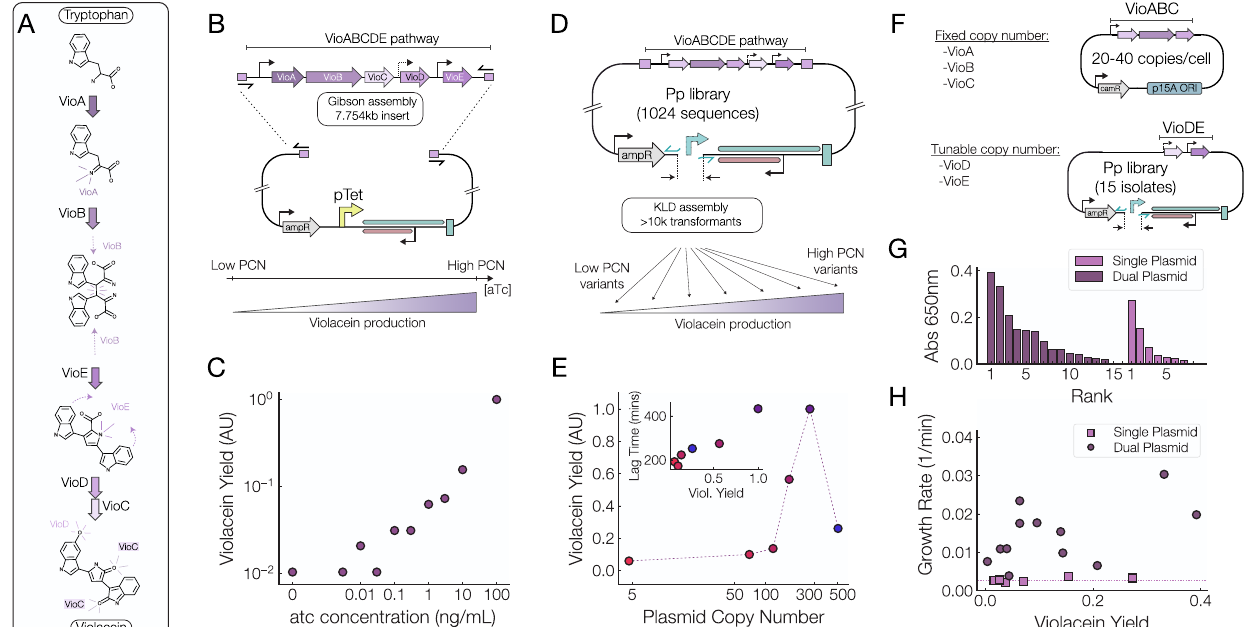
Fig. 5 Optimization of violacein production by tuning plasmid copy number. A The action of 5 enzymes on two tryptophan molecules yields violacein ( B ) The complete VioABCDE pathway was inserted in the pUC-pTet plasmid. C Violacein production scales with aTc concentration when the pathway is inserted into the pUC-pTet plasmid. D A library of variable copy number plasmids containing the VioABCDE pathway was created by performing mutagenesis on the priming promoter of a ColE1-based plasmid. E Violacein production is can be scaled up or down by plasmid copy number. At very high copy number production is low due to increased metabolic burden. Inset: Lag time is drastically increased in constructs with high violacein production. Error bars = std. dev. ( n = 4). F A two plasmid system was created in which the VioABC enzymes were placed on a single plasmid of fi xed copy number and the VioDE were placed in our library of variable copy number plasmids. G The use of a two plasmid system outperforms a the single plasmid system in raw violacein yields. H Growth rate is dramatically improved with a two plasmid system. Our randomized approach leads to the creation of constructs with fast growth rates and high amounts of violacein